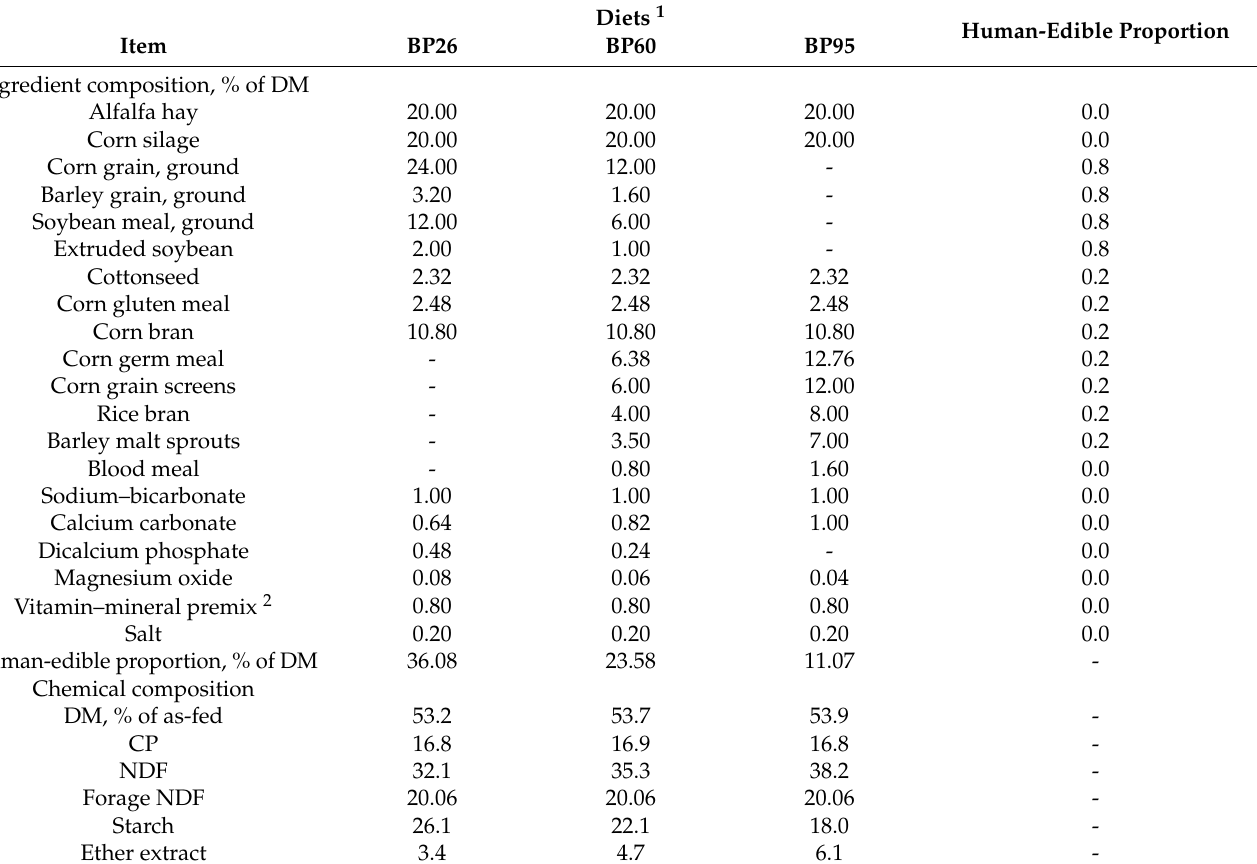
Table 1. Ingredient and chemical composition of experimental diets (DM basis) and estimated proportion of human